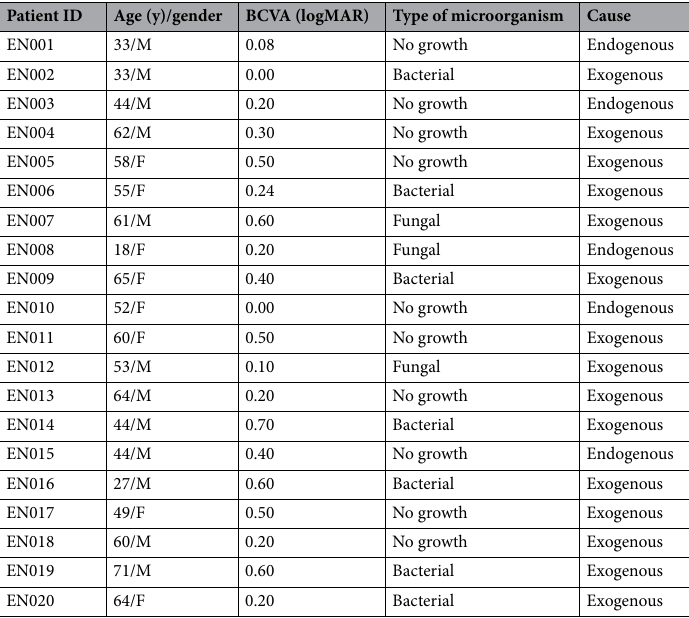
Table 1. Visual acuity and patient profile among the patients with resolved